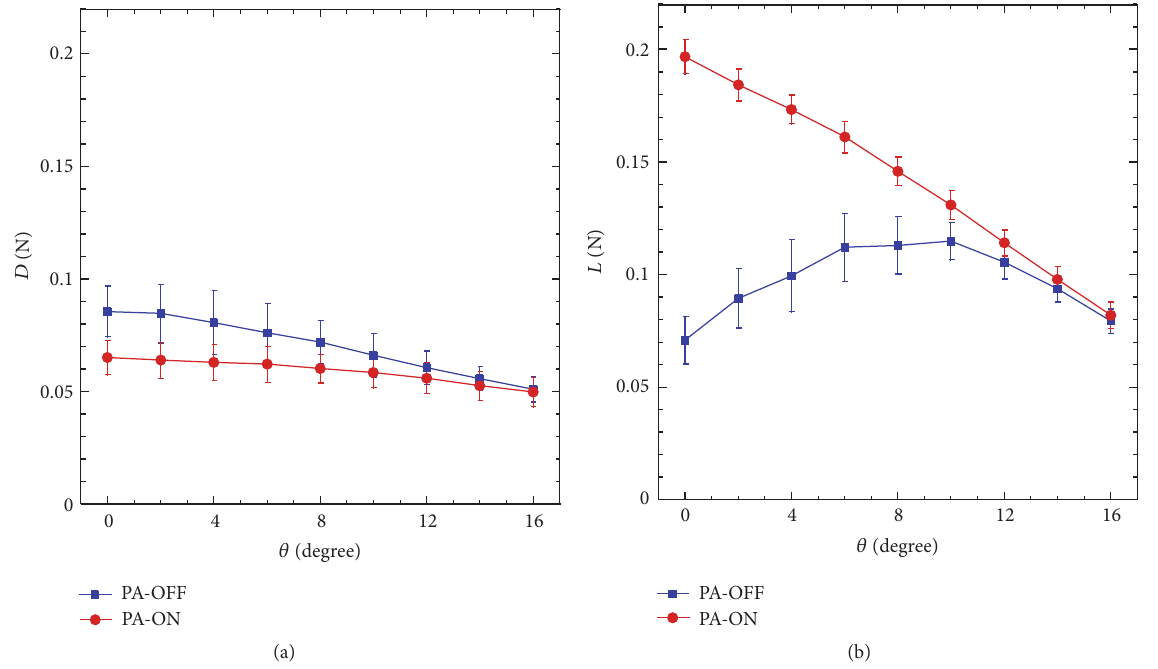
Figure 11: Enhancements of aerodynamic properties by open-loop control of flow separation, (a) drag force; (b) lift force.